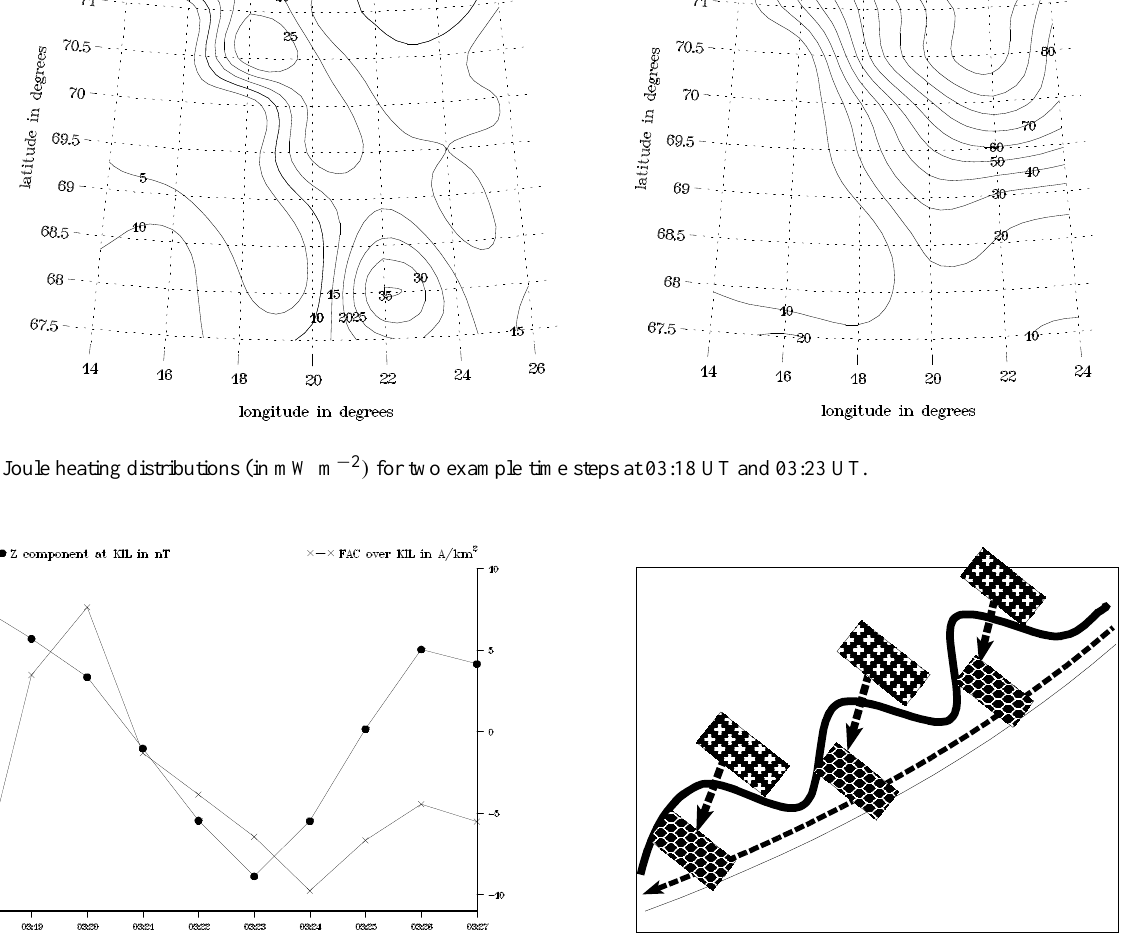
Fig. 12. Comparison of the Z magnetic disturbance component at KIL (dots, scale on the left side of graph), and the FAC density directly above KIL as inferred from the results of the method of characteristics (crosses, scale on the right side of the graph).